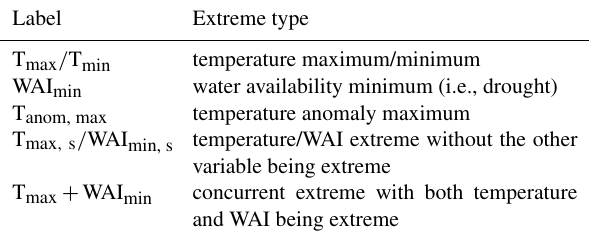
Table 1. Overview of different extreme-event types and the suffixes denoting them.